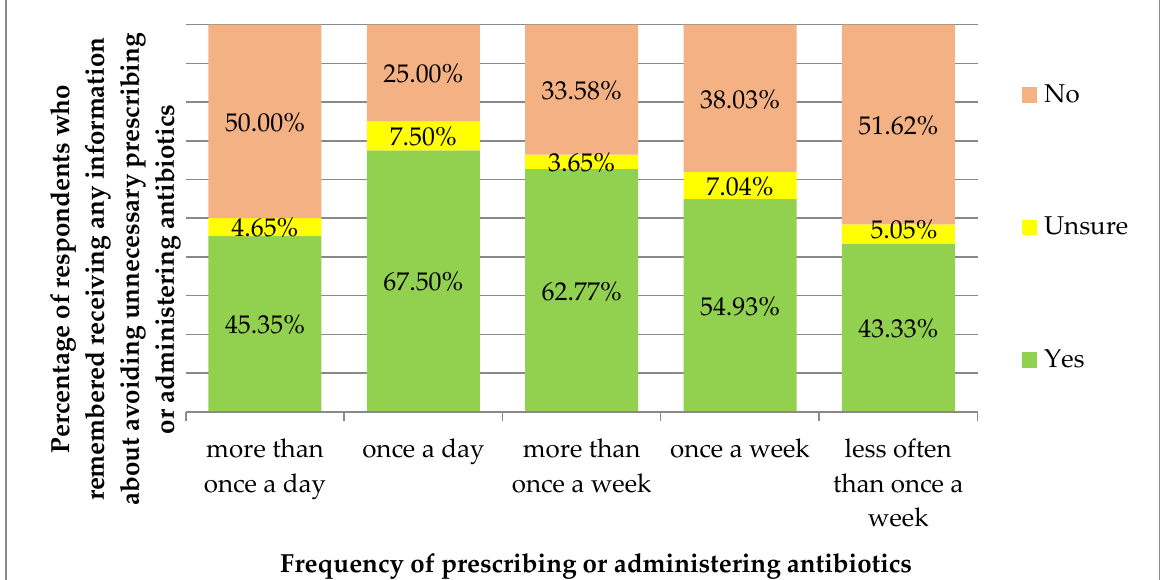
Figure 3. Percentage of respondents who remembered receiving any information about avoiding unnecessary prescribing or administering or dispensing of antibiotics, by the frequency of prescribing or administering antibiotics.